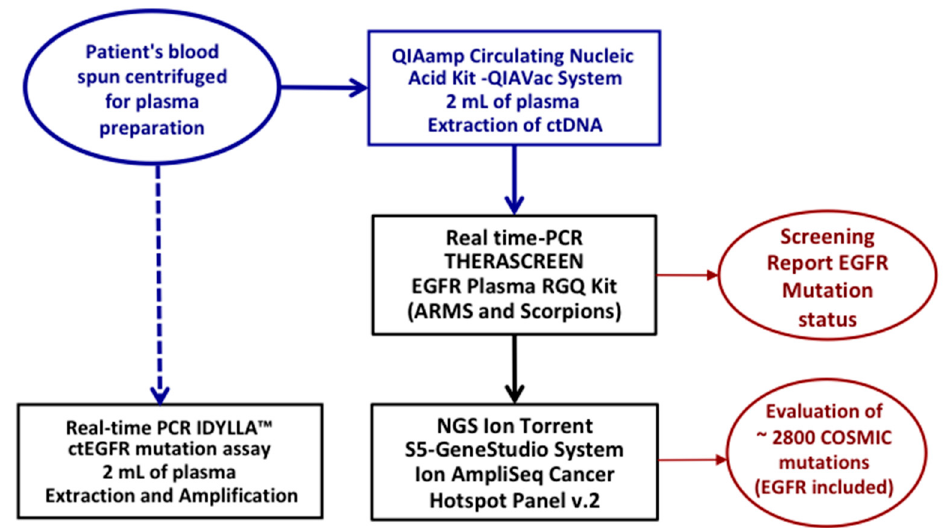
Figure 2. Flow chart of the molecular screening process of the samples included in the study.